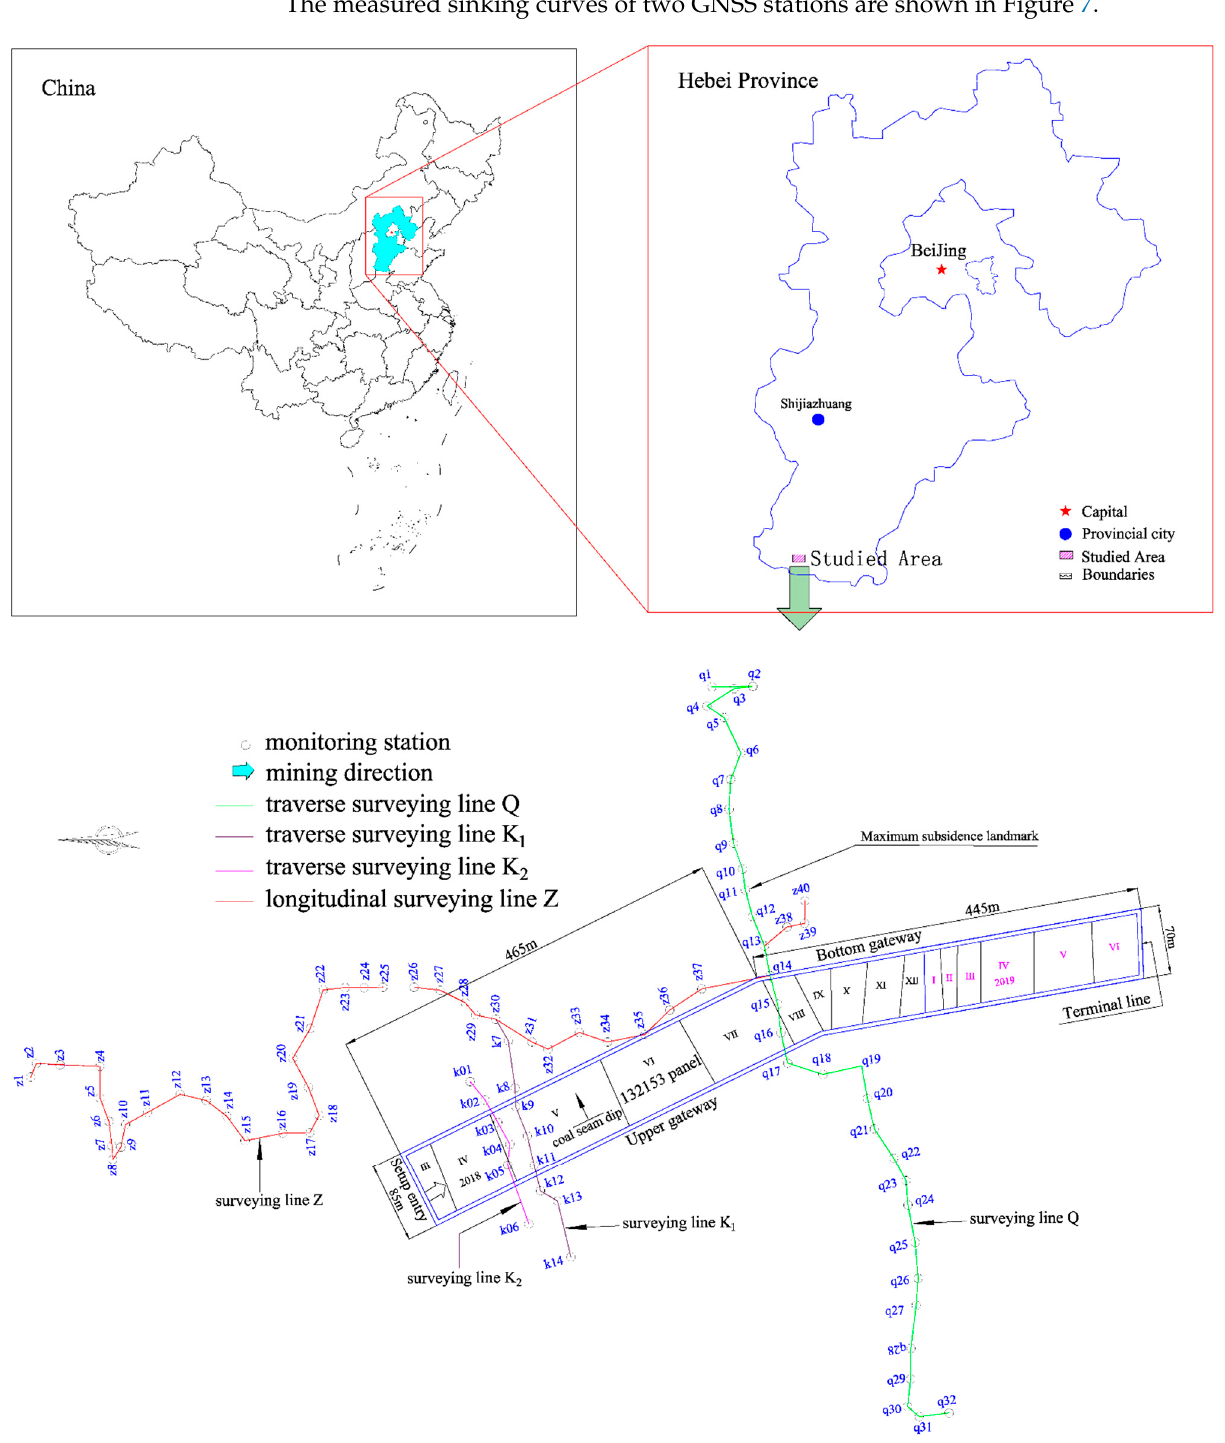
Figure 4. Schematic diagram of the Wannian coalmine location and layout of surface movement monitoring landmarks above 15235 workface.